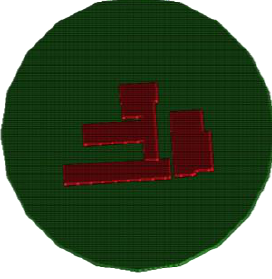
Figure 5. Ground Points (Green) and Building Points (Red)